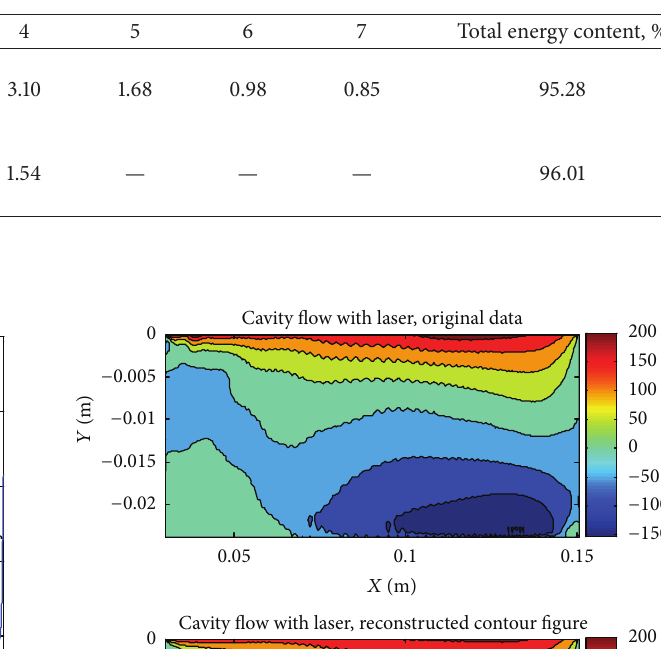
Cavity flow with laser, reconstructed contour figure